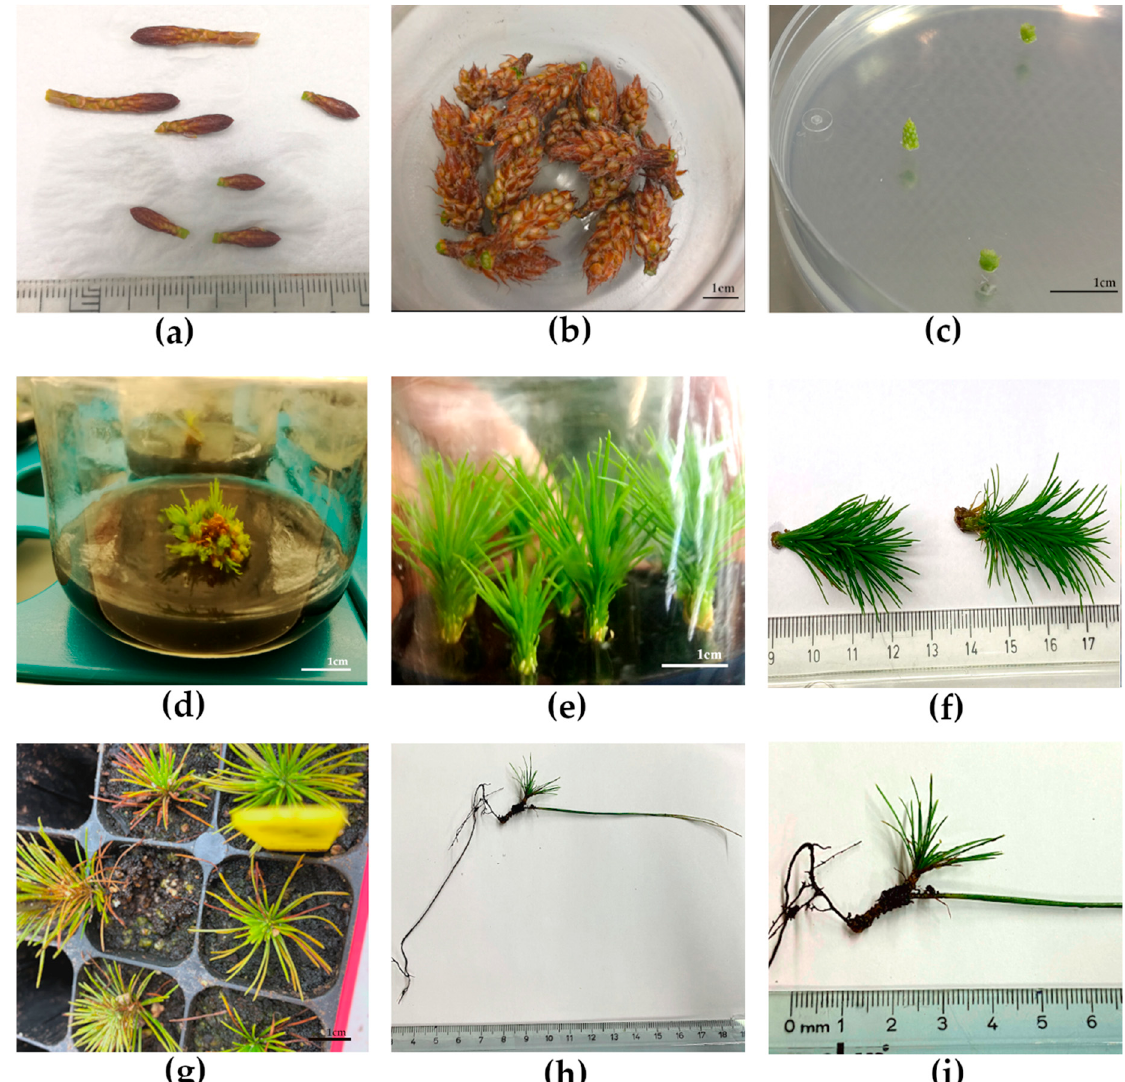
Figure 1. Plant material at different stages of the organogenic process: ( a ) apical shoot buds with different sizes and totally closed scales; ( b ) apical shoot buds at an advanced developmental stage with open scales; ( c ) bud slices in the induction medium; ( d ) shoot organogenesis in a bud slice cultured in the elongation medium; ( e ) axillary shoots separately cultured in the elongation medium; ( f ) shoots with no roots immediately before acclimatization; ( g ) acclimatized shoots; ( h ) acclimatized shoot removed from the container to display the ex vitro developed roots; ( i ) closer view of the latter acclimatized shoot. Table 1. Variations of basal DCR medium [27] used along different stages of P. halepensis organogenesis (O1–O3) and embryogenic tissue induction (S1–S10).